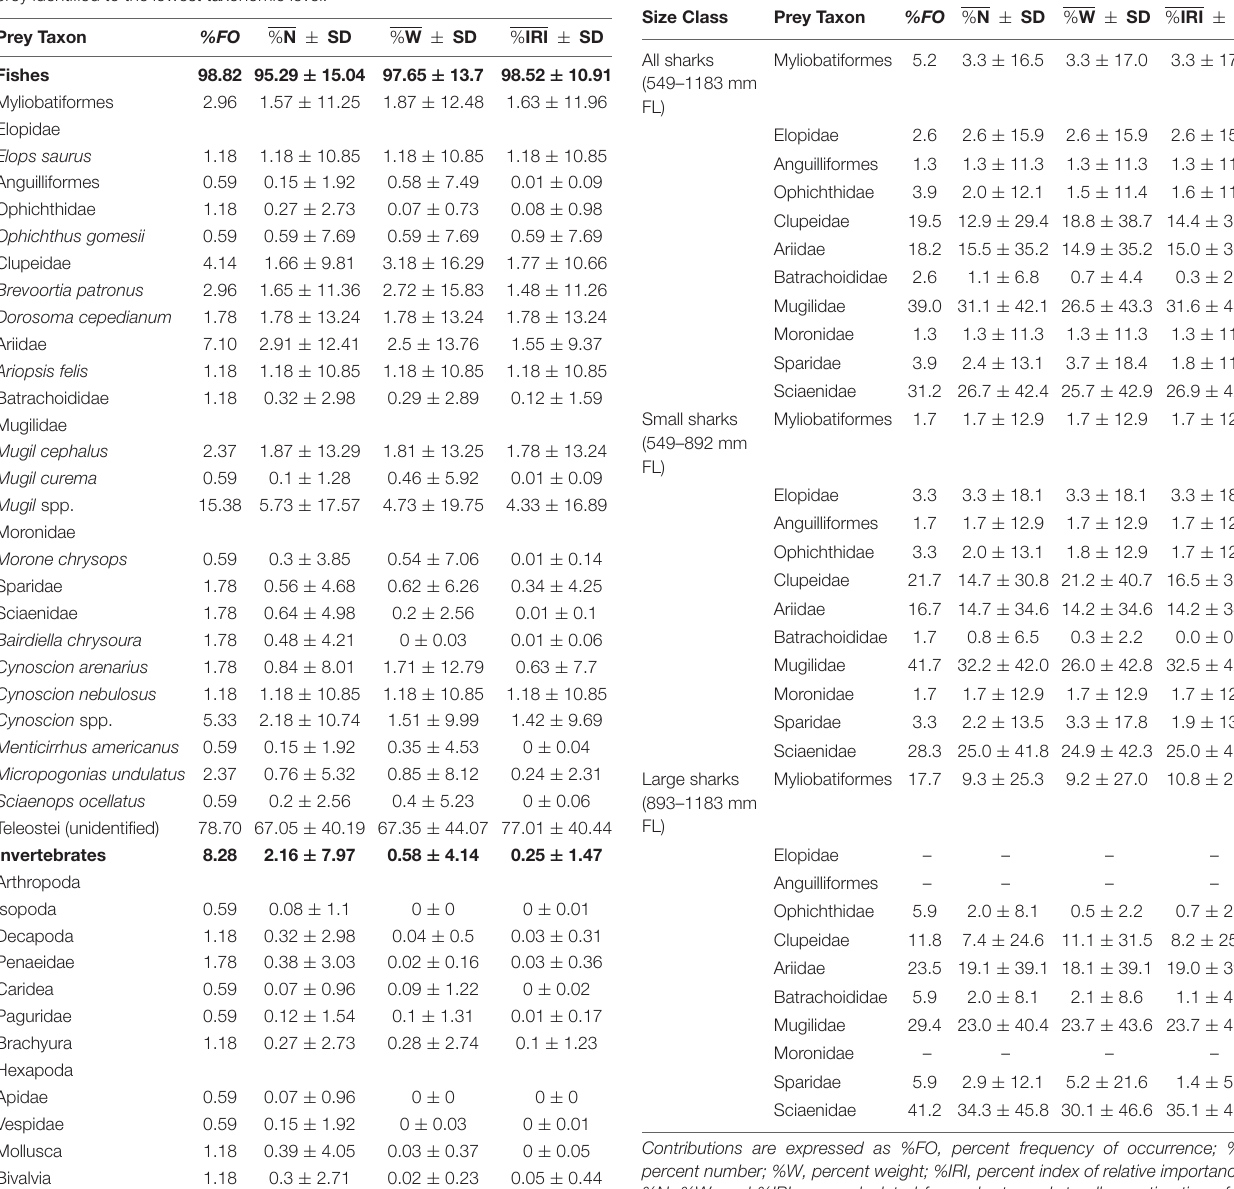
TABLE 1 | Dietary composition of bull sharks ( Carcharhinus leucas ) from nwGoM estuaries expressed as percent frequency of occurrence (%FO ), percent number ( %N ), percent weight ( %W ), and percent index of relative importance ( %IRI ) for prey identified to the lowest taxonomic level.